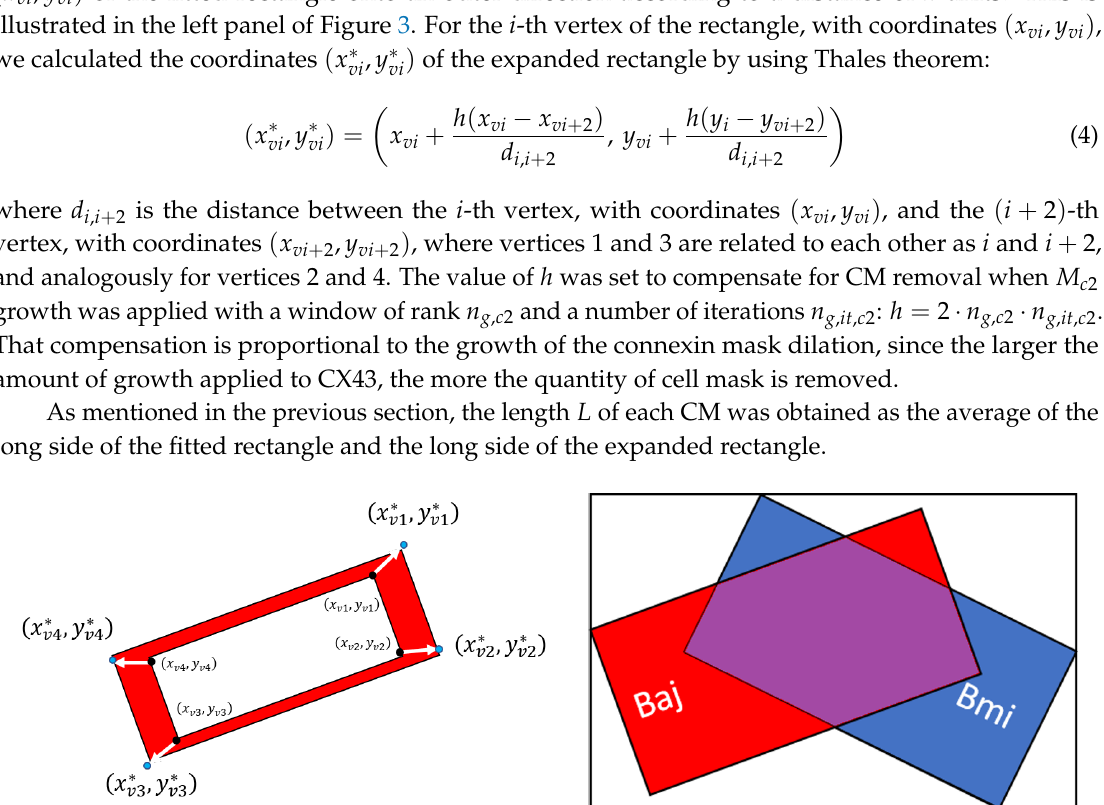
shows the enclosing rectangle for a CM in the i ∩ A m j i